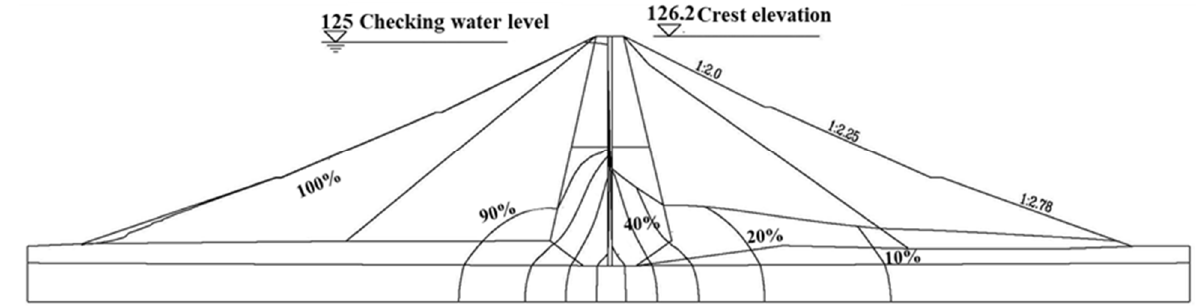
Figure 9. Isograms of equipotential line for the main dam using the common method.